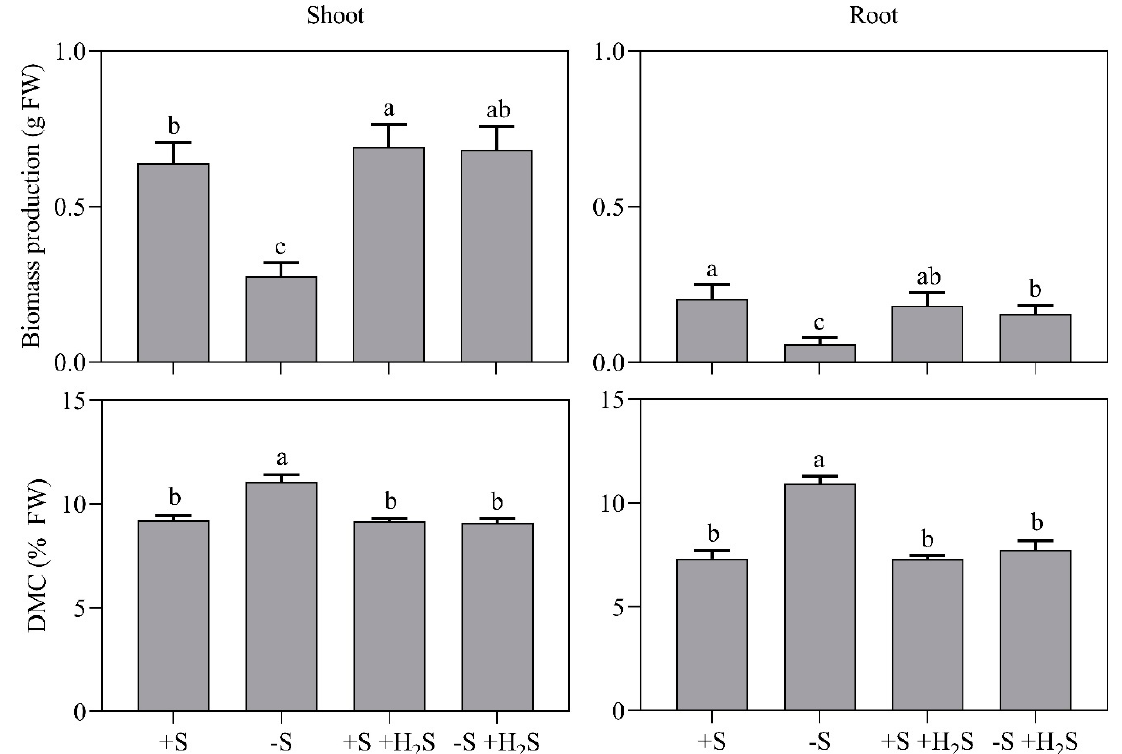
Figure 1. Biomass production and dry matter content (DMC) of barley shoots and roots in the presence and absence of a H 2 S and sulfate supply. Seven-day old seedlings were grown on a 50% Hoagland nutrient solution at 1 mM ( + S) or 0 mM sulfate ( − S) and exposed to 0 or 0.6 µ L L − 1 H 2 S for 7 days. The initial shoot and root weights were 0.16 ± 0.01 and 0.08 ± 0.01 g FW, respectively. Data on biomass production represent the average of 2 experiments with 12–13 measurements with 3-6 plants per measurement ( ± SD). Data on DMC represent the average of 3 measurements with 6 plants per measurement ( ± SD). Significant di ff erences between treatments are indicated with di ff erent letters ( P ≤ 0.05; two-way ANOVA; Tukey’s HSD test as a post-hoc test).